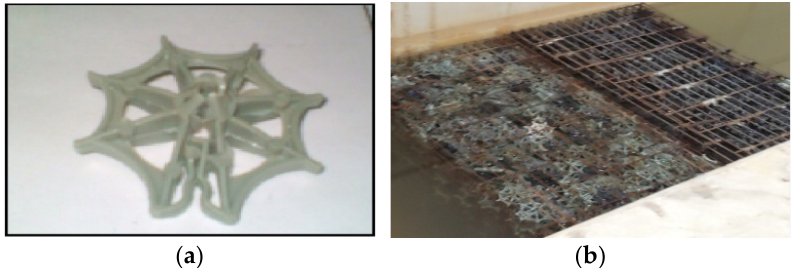
Figure 4. The plastic media used in this study (star shape). ( a ) Star shape media, ( b ) The biofilter.